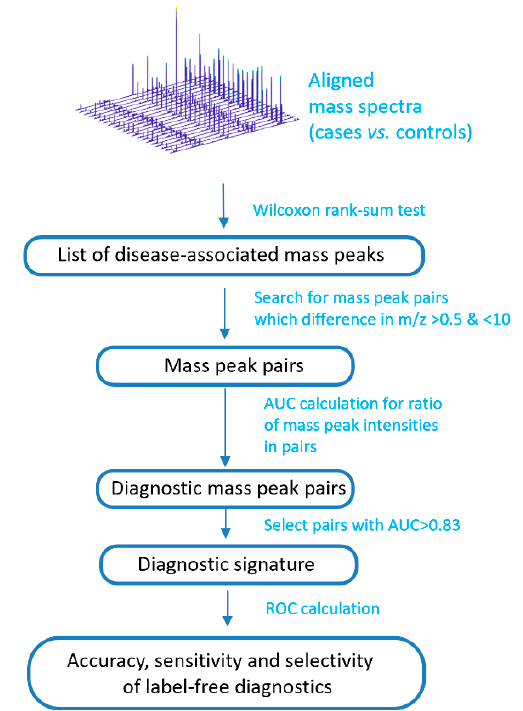
Figure 2. Schema to compile a label-free diagnostic signature based on direct-infusion mass spectrometry data. ROC: receiver operating characteristic; AUC: area under ROC